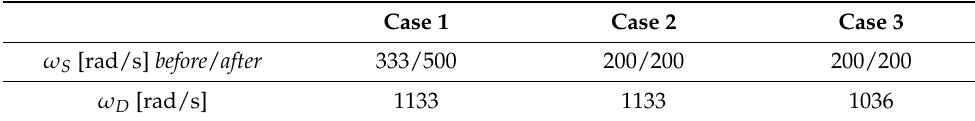
Table 4. Control bandwidths